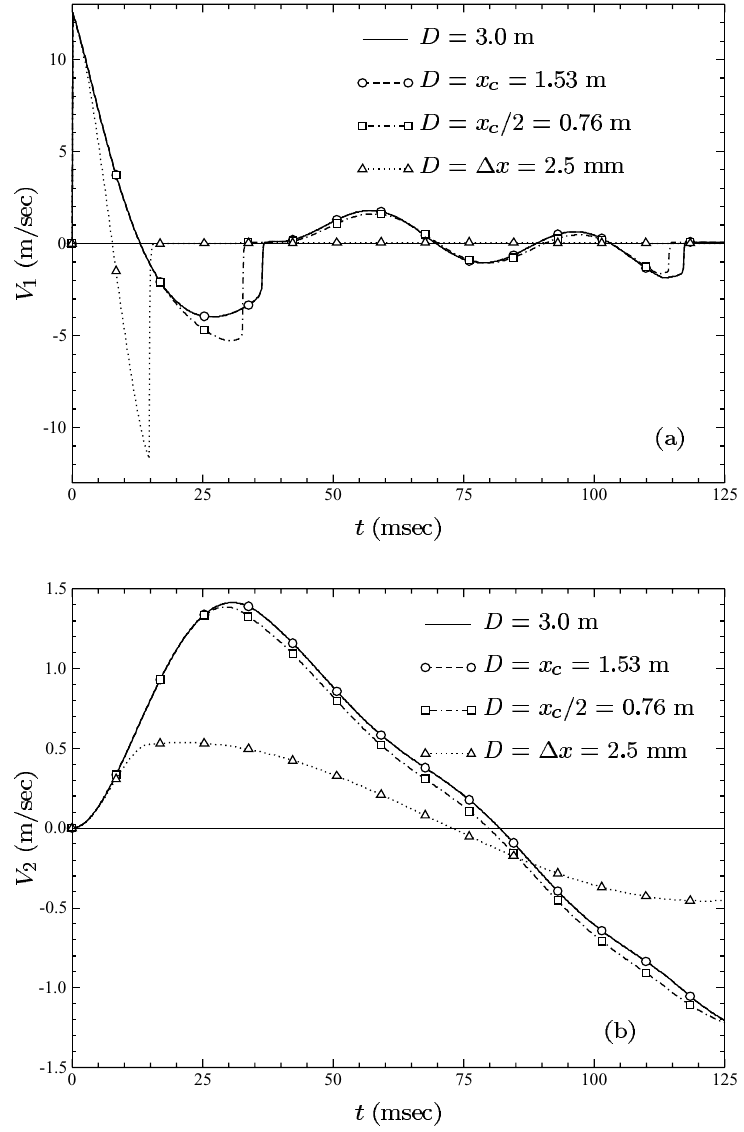
Fig. 10. (a) V 1 - and (b) V 2 -response histories for M 2 /M 1 = 25 , demonstrating the performance of truncated CAFE